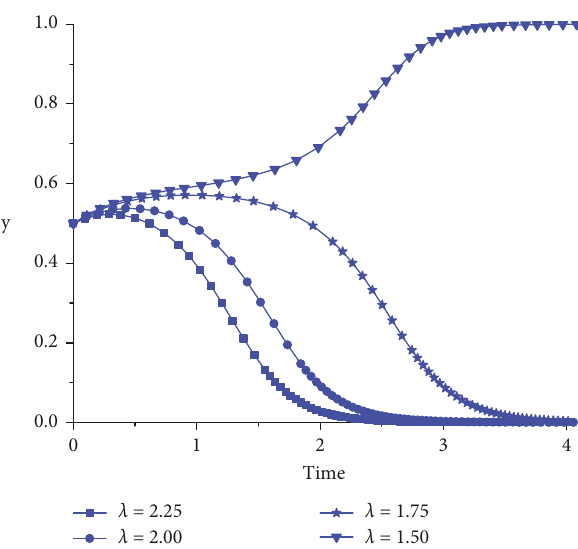
Figure 17: Impact of loss aversion coefficient on enterprise